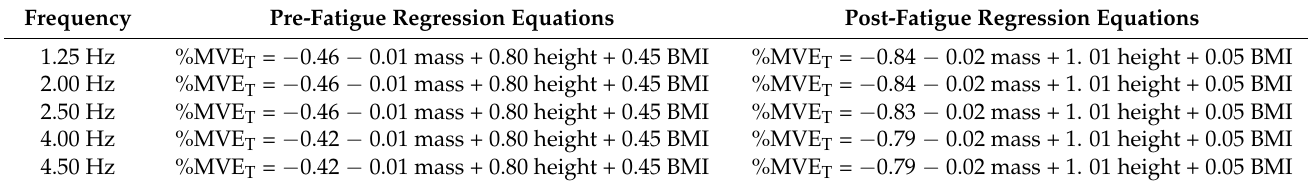
Table 4. Stepwise regression models for %MVE T (transformed % maximum voluntary electrical activation data) of the internal oblique pre-and post-back muscle fatigue, where mass, height, and body mass index (BMI) are continuous predictors, and vibration frequency is a categorical